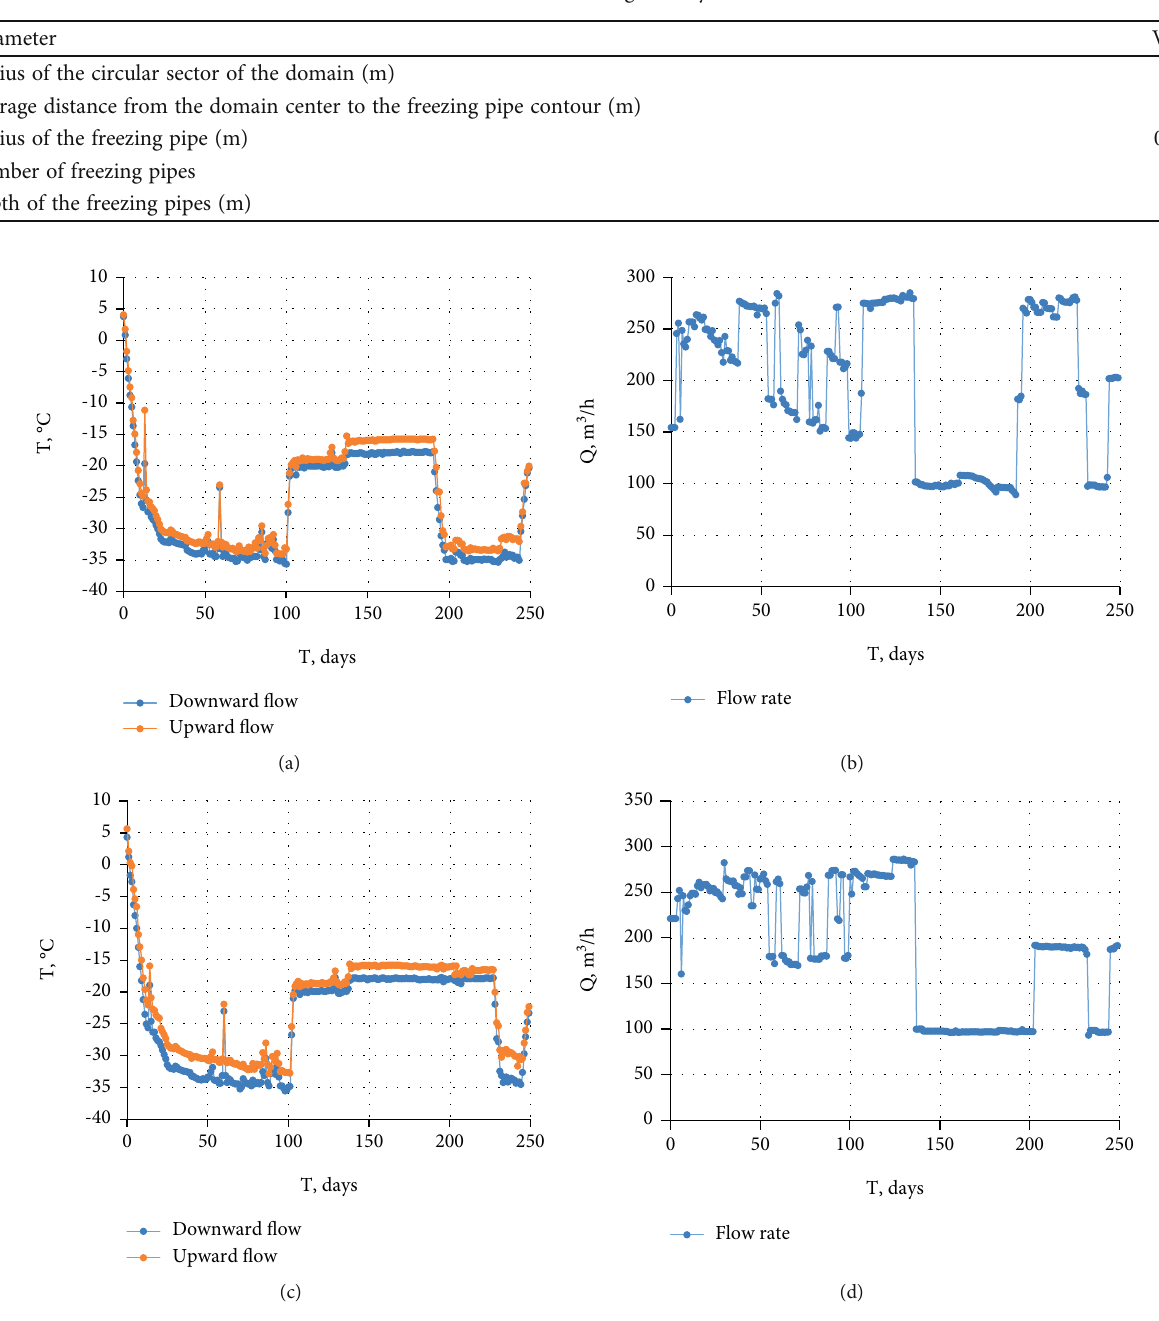
Table 2: Problem geometry.